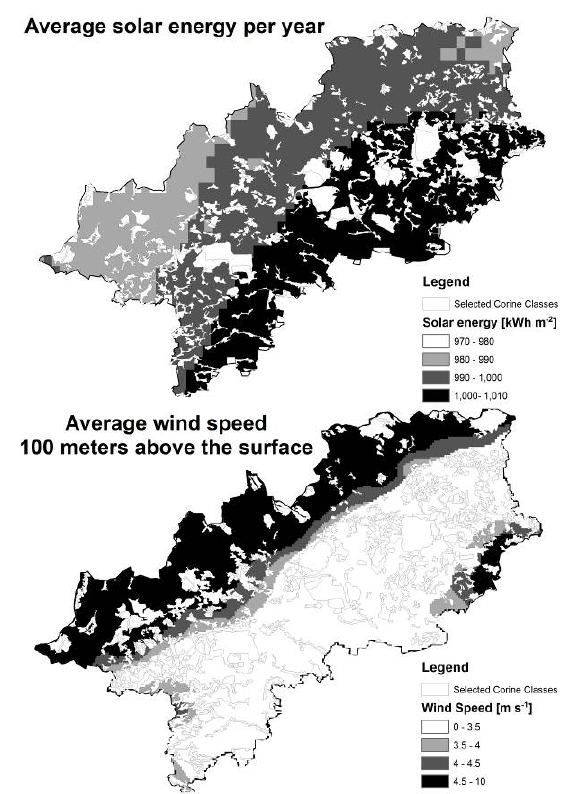
Figure 6. Average solar energy per year and estimation of the average wind speed 10 meters above the surface.